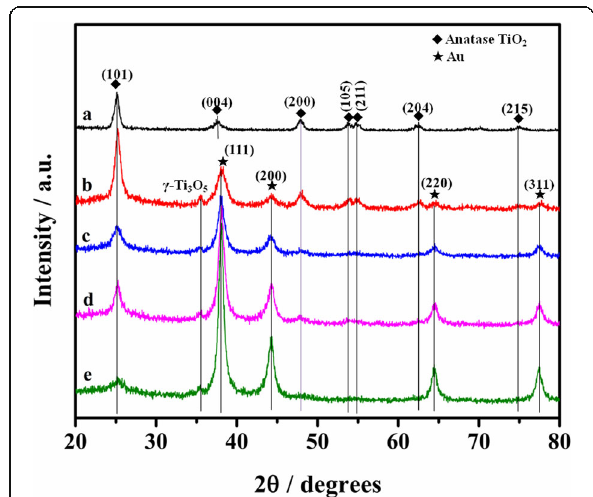
Fig. 2 XRD patterns. a TiO 2 . b Au-30@TiO 2 . c Au-50@TiO 2 . d Au-80@TiO 2 . e Au-120@TiO